Question: Draft a figure caption describing what is shown.
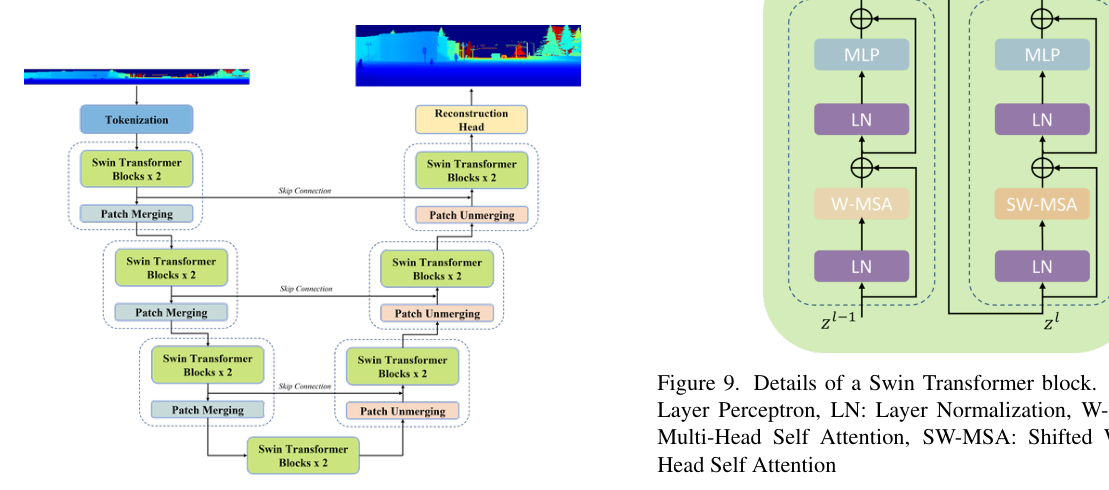
Answer: Network Architecture of TULIP: The network has a symmetric design in the encoder and decoder. Each layer in the en- coder consists of two Swin Transformer blocks and a patch merg- ing layer which downscales the spatial resolution of feature maps. For the decoder, a patch unmerging layer succeeds two subsequent blocks for upscaling. A bottleneck layer is applied between the en- coder and decoder to enhance the high-level feature representation. The range image is pre-processed with logarithmic transformation before being fed into the network.